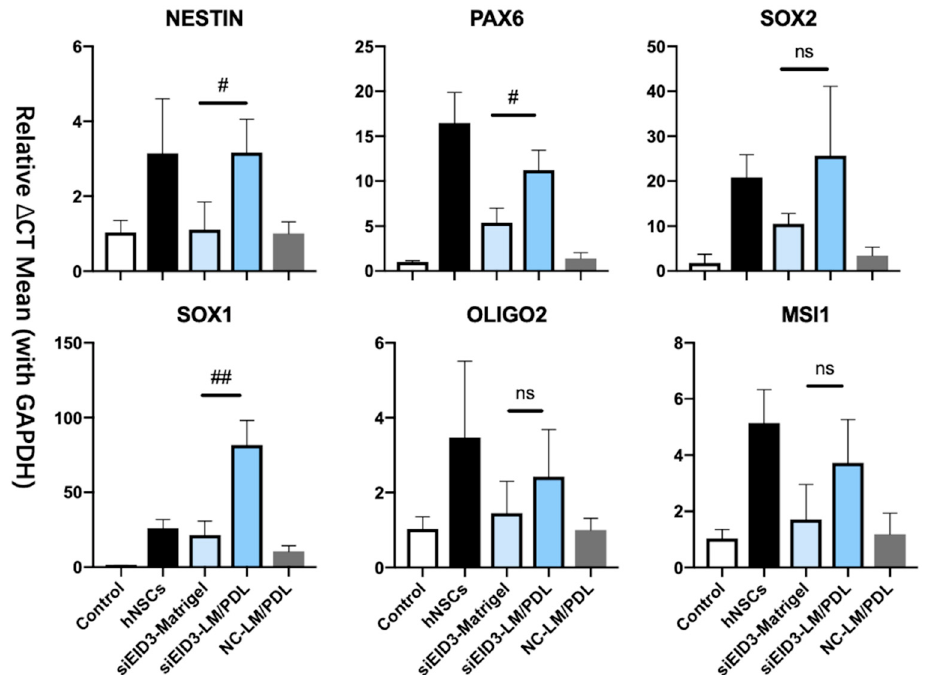
Figure 5. Characterization of iNPLCs differentiated from tdASC by different methods. Real-time qRT-PCR of the iNPLC and early NSC markers NESTIN, PAX6, SOX2, SOX1, OLIGO2, and MSI1 (Musashi-1) in each experimental group. Control, negative siRNA control; hNSCs, commercial human NSCs; LM/PDL, laminin/poly- D -lysine. The mRNA level of each group was normalized to the corresponding GAPDH level. The bars represent the mean ± SEM of at least three independent experiments. n = 3; # p < 0.05; ## p < 0.01; data compared to the control group (hADSCs); ns, not significant; data are presented as the mean SEM.